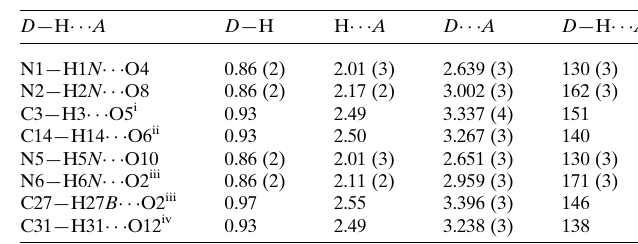
Table 1 Hydrogen-bond geometry (A˚ , (cid:2) ).